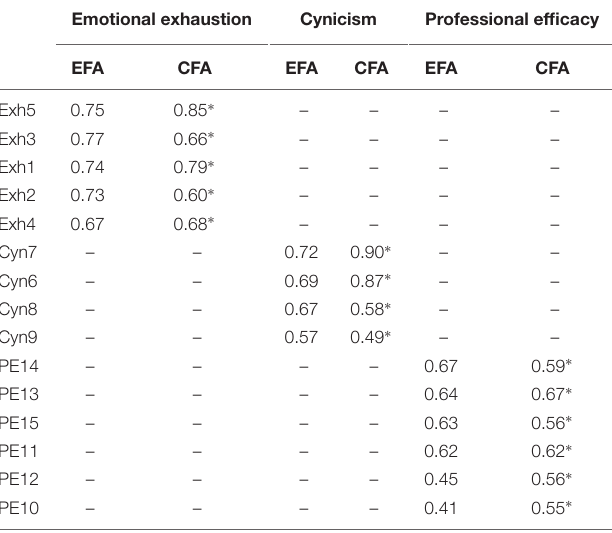
TABLE 1 | Factor pattern matrix for the Italian version of the